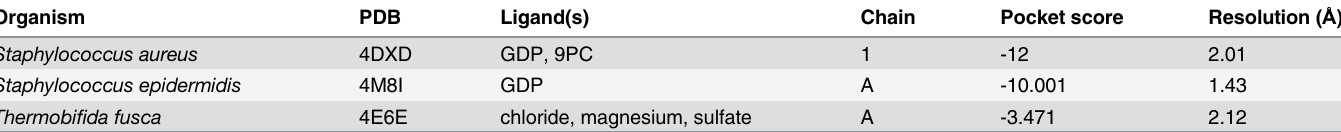
to PC190723 binding. Notably, binding site microenvironment comparison performed by PocketFEATURE captures details that are not detected solely through structural analysis. Root mean squared deviation (RMSD) of the pockets of the crystal structures to the pocket of the Sa FtsZ-PC190723 co-crystal (Fig. 2B) clearly identified that Staphylococcus species have pocket structures that are more similar to that of the Sa FtsZ-PC190723 co-crystal, but in contrast to PocketFEATURE, RMSD is unable to distinguish among non- Staphylococcus species.